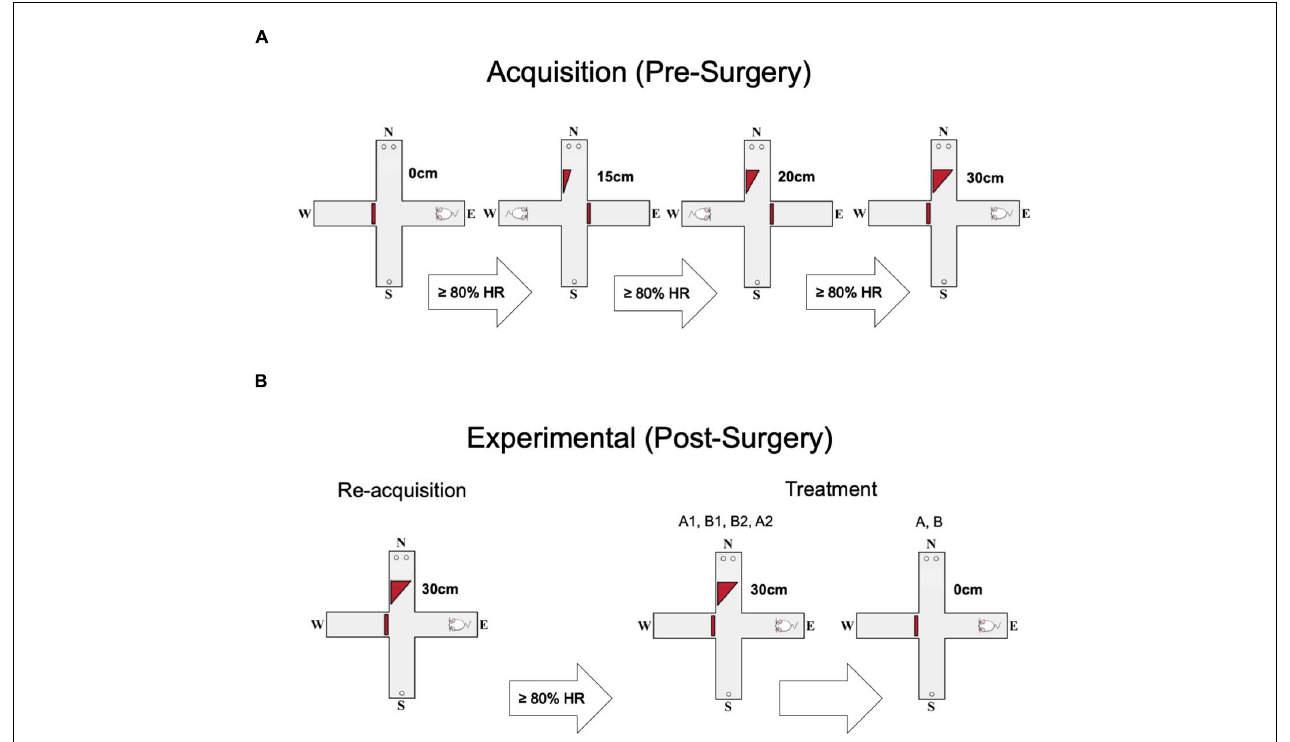
FIGURE 1 | Behavioral protocol. (A) Each animal went through four stages of acquisition, progressing to the next ramp height (0 cm, 15 cm, 20 cm, 30 cm) after making ≥ 80% high reward (HR) choices. The animals’ starting arm varied pseudorandomly. (B) Each animal was required to pass a short re-acquisition phase post-surgery, but before experimental trials. Again they were required to make ≥ 80% HR choices. The experimental phase consisted of two parts. Each animal did two control sessions (A1, A2) and two inactivation sessions (B1, B2). Then, the ramp was removed and the animals did two more sessions, one inactivation and one saline (A,